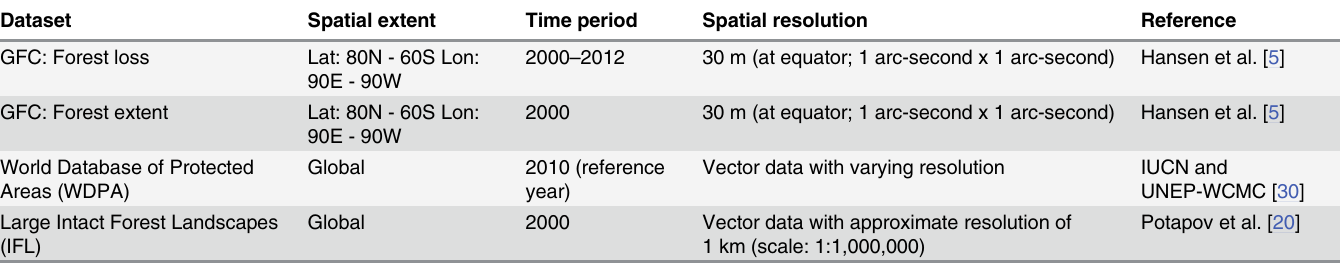
Table 2. A description of the datasets used in this study. GFC stands for Global Forest Change dataset.